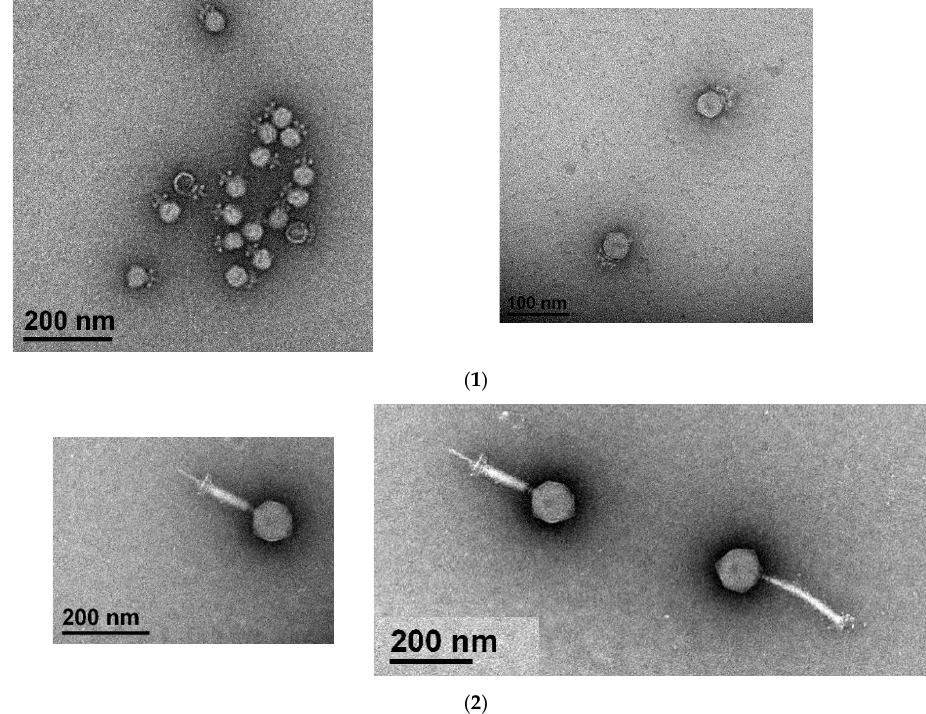
Figure 1. Visualization of phages MDA1 ( 1 ) and MDA2 ( 2 ) under the electron microscope. Scale bars indicate 100 nm and 200 nm. The genomes of MDA1 and MDA2 were 18,058 bp and 140,226 bp long, respectively. MDA1’s linear genome had a GC content of 33% (Figure 2). No tRNA was found in the genome. When compared to other published enterococcal genomes, phage MDA1’s ge- nome had 82% homology with Enterococcus phage vB_Efae230P-4 (Figure S1) [51]. Phage MDA2 had a circular genome with a GC content of 35.8%, which was similar to that of other enterococcal phages and of its enterococcal hosts (38%) [51–53]. Six tRNAs were found in its genome. tRNAs are usually present in the phage genome as a result of vari- ance in codon usage between their genome and their host’s genome, enabling phages to bypass codons overused in the phage genes and compensate for the extra bias [54,55]. The linearized genome of phage MDA2 is represented in Figure 3. When compared to other published enterococcal genomes, the genome of MDA2 was 70%, similar to that of phage phiEF24C [56]. Both Podoviridae vB_Efae230P-4 and Myoviridae phiEF24C were isolated from the environment in Japan and targeted vancomycin-resistant E. faecalis [51,56] (Fig- ure S2). Of interest, no virulence-associated genes, antibiotic resistance genes or integrase genes were detected in the phages’ genomes (Tables S1 and S2).